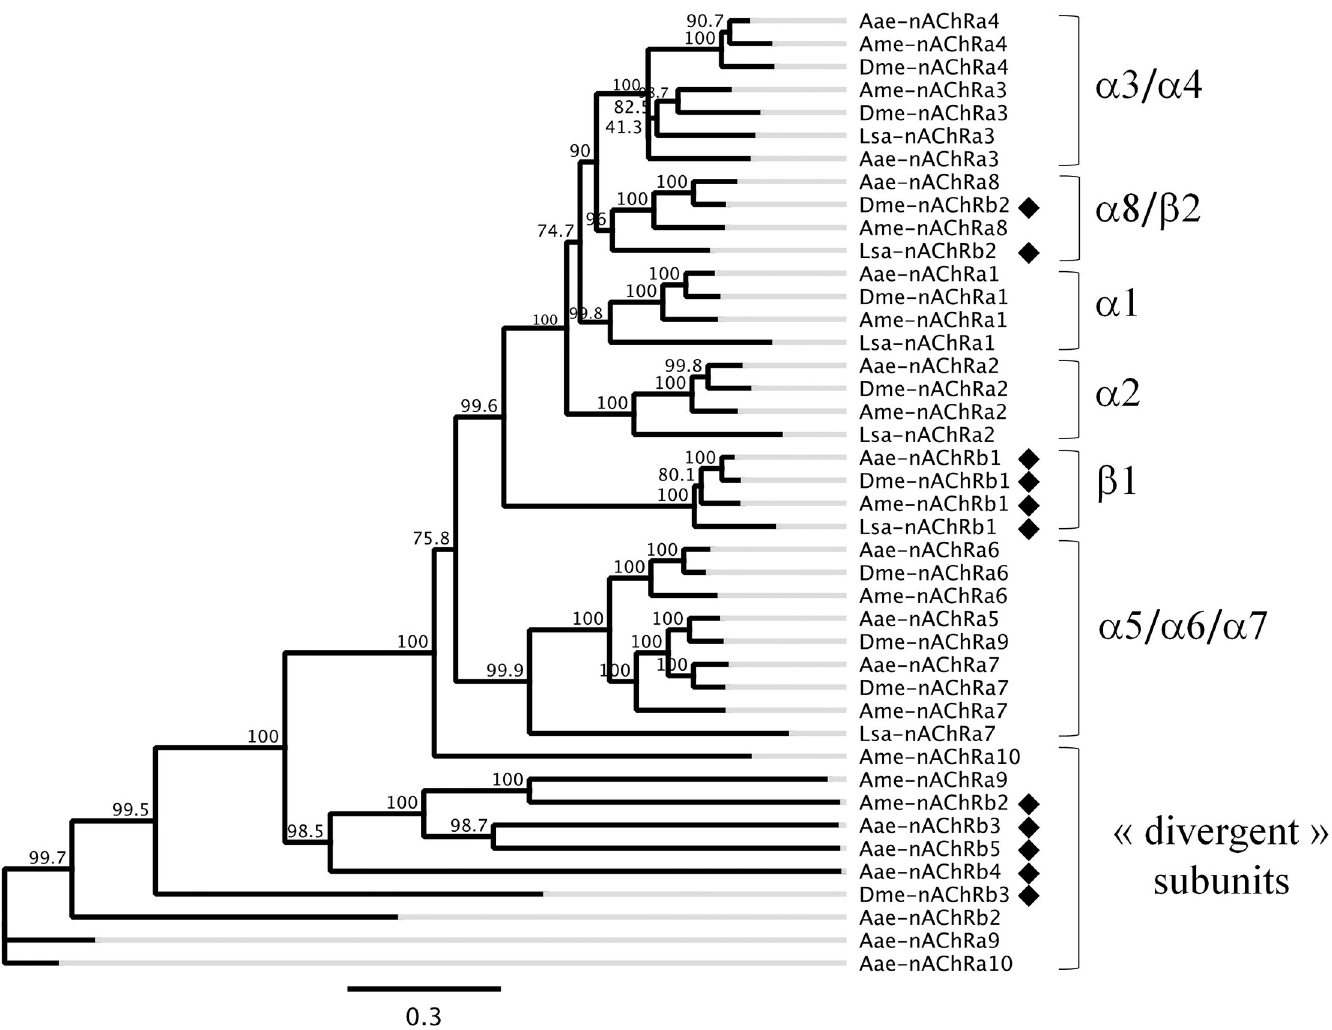
Fig 1. Phylogenetic relations of L . salmonis nAChR subunits. Consensus phylogram constructed using full-length nAChRs subunits (amino acid sequences) from Lepeophtheirus salmonis (Lsa), Apis melifera (Ama), Drosophila melanogaster (Dme) and Aedes aegypti (Aae). Branch labels indicate the consensus support in percent. The tree was constructed using a maximum likelihood approach (PhyML 3.0) and a bootstrap with 1000 iterations. The scale bar represents 0.3 substitutions per site. Black diamonds indicate β